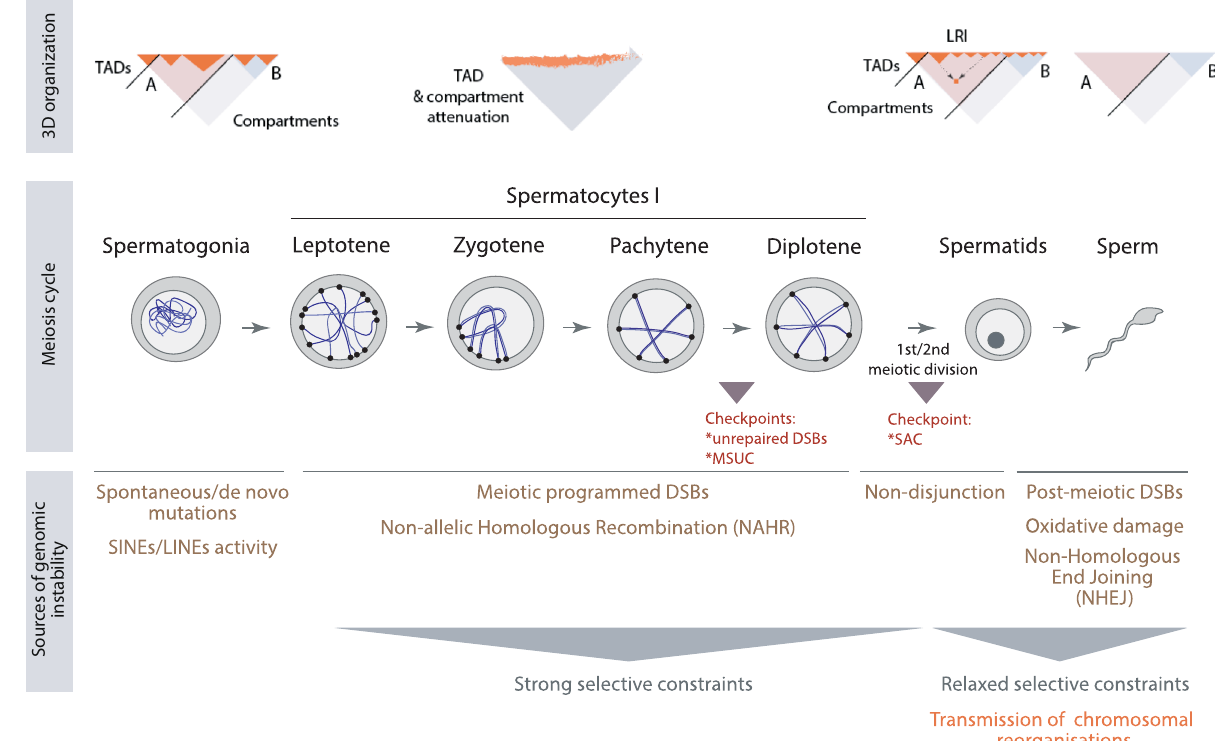
Fig. 6 Working model on how chromatin structure of germs cells modulates genome evolutionary plasticity. Upper panel: 3D organisation of meiotic cells. Spermatogonia present a somatic-like organisation with the genome folded into compartments (A and B) and subsequent TADs. Subsequently, there is an attenuation of compartments and TADs in primary spermatocytes (here exempli fi ed as leptotene, zygotene, pachytene and diplotene stages). Post- meiotic cells (round spermatids and spermatozoa) recover a somatic-like con fi guration, although with particularities such as that TAD borders are not clearly de fi ned, and long-range interactions appear 12,49 . Middle panel: Meiotic progression and checkpoints, Self-renewing spermatogonia commit to meiosis. The primary spermatocytes meiotic prophase I, which is subdivided into four stages: leptotene, zygotene, pachytene and diplotene. The fi rst and second meiotic divisions result in round spermatids, which differentiate into sperm 70 . Meiosis includes three meiotic checkpoints: (i) response to unrepaired double-strand breaks (DSBs), (ii) transcriptional repression called meiotic silencing of unsynapsed chromatin (MSUC), and (iii) the spindle assembly checkpoint (SAC). Lower panel : Sources of genomic instability. Spontaneous/de novo mutations and SINEs/LINEs activity predominate in spermatogonia. Meiotic programmed DSBs and its repair through non-allelic homologous recombination (NAHR) are sources of structural genomic changes during prophase I, together with non-disjunction during the subsequent meiotic divisions. The resulting structural changes are under strong selective constrains since errors can be detected by either of the meiotic checkpoints in play. In the case of post-meiotic cells (i.e., sperm) genomic instability can result from oxidative damage and DSBs produced by topoisomerase II DNA disentangling. The repair of DSBs is normally taken place by non- homologous end joining (NHEJ), an error-prone process that can result in structural genomic changes. As no checkpoints are activated in this stage (hence, relaxed selective constrains), there is a high likelihood that chromosomal reorganisations are transmitted to the offspring. Abbreviations – LRIs long-ranged interactions, TADs topological associated